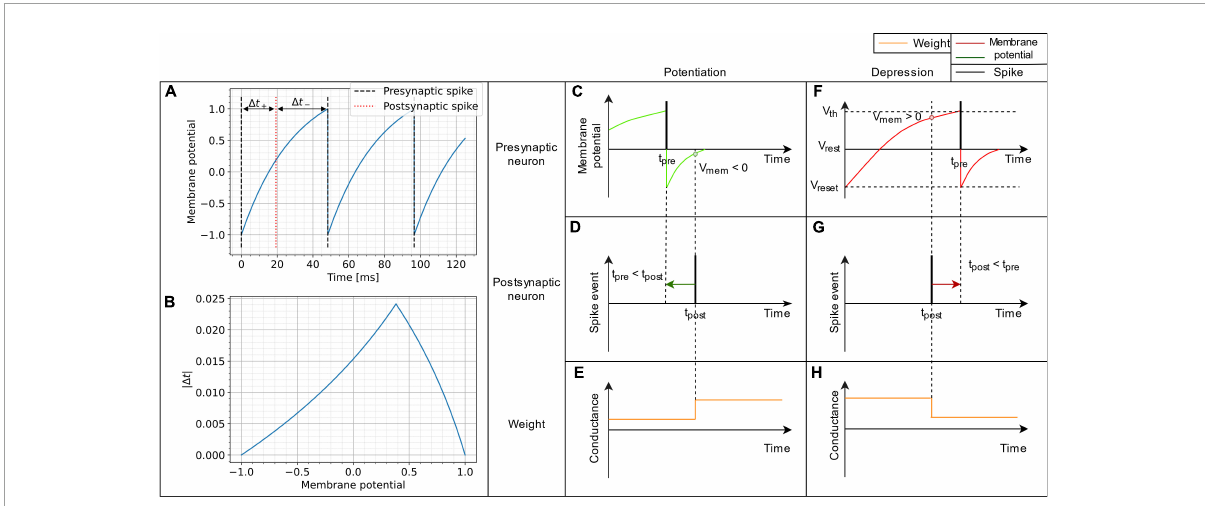
FIGURE1 Schematic representation of the VDSP learning rule implemented between a pre- and postsynaptic spiking neuron. In (A) , the membrane potential of a LIF neuron is shown evolving through time when fed with a constant current. In (B) , the absolute time difference between the post and presynaptic spikes is computed analytically as a function of the membrane potential from (A) . It is trivial, once the spike time difference is computed, to determine the STDP window as a function of membrane potential. (C,F) Show the spiking event of the presynaptic neuron (vertical black line) along with its membrane potential (colored curve). (D,G) Show the spike event of the postsynaptic neuron. The weight update (E,H) happens whenever the post-synaptic neuron fires. The update is dependent on the membrane potential of pre-synaptic neuron. If the pre-synaptic neuron fired in the recent past (t pre < t post ), the membrane potential of the presynaptic neuron is lesser than zero, and we observe potentiation of synaptic weight (C–E) . Whereas if the pre-synaptic neuron is about to fire (t post < t pre ), the membrane potential of the pre-synaptic neuron is greater than zero and we observe depression of synaptic weight (F–H) .